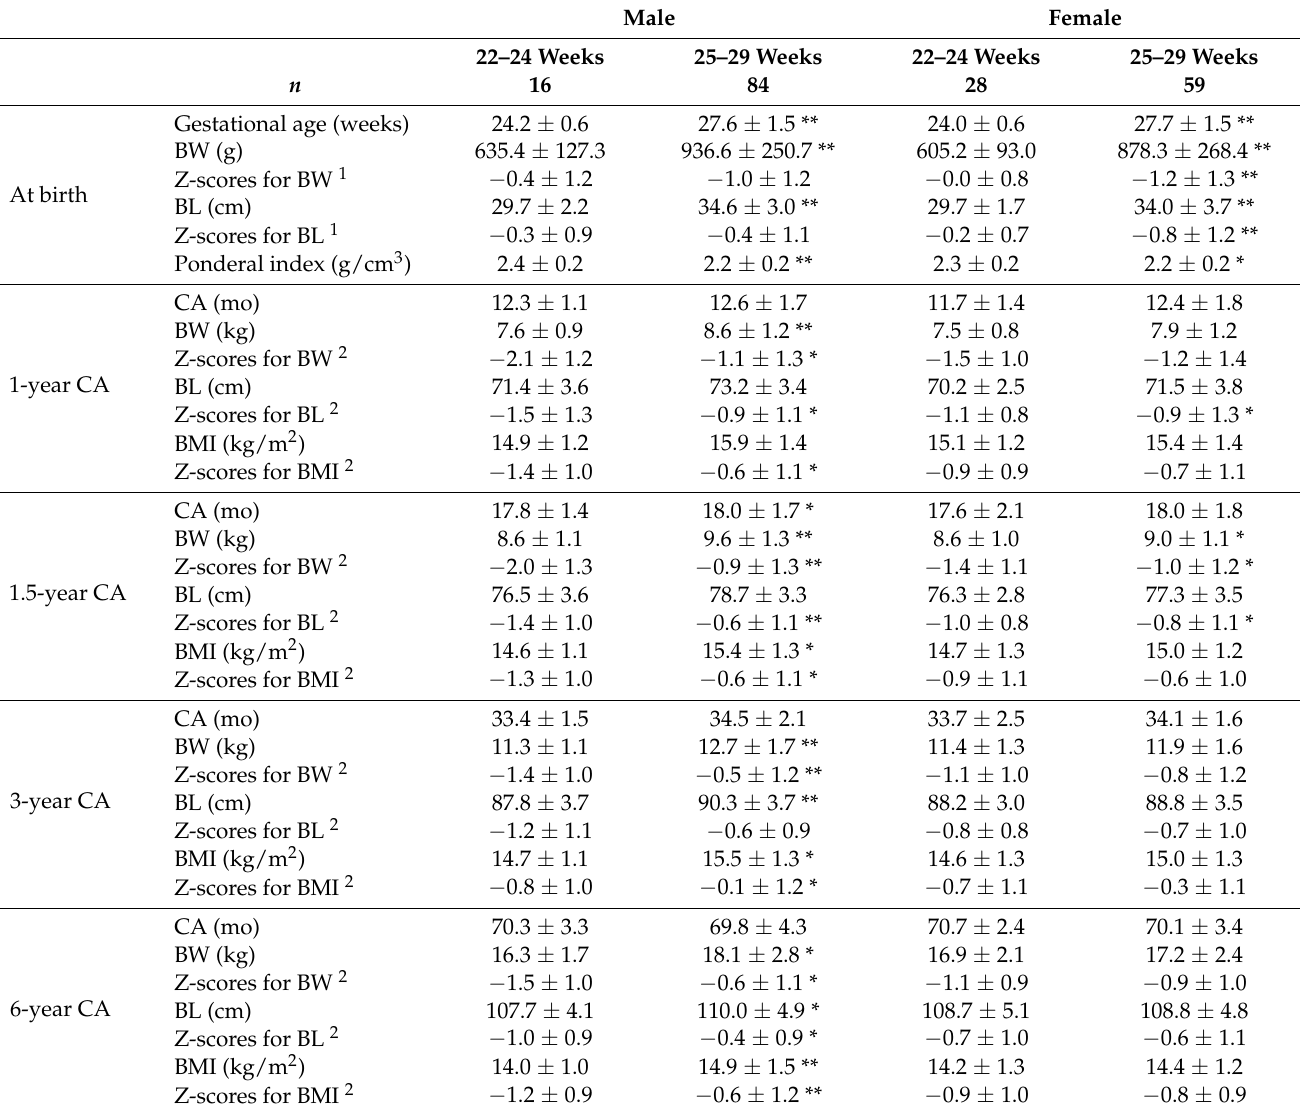
Table 1. Anthropometric indices of children from birth to 6 years of